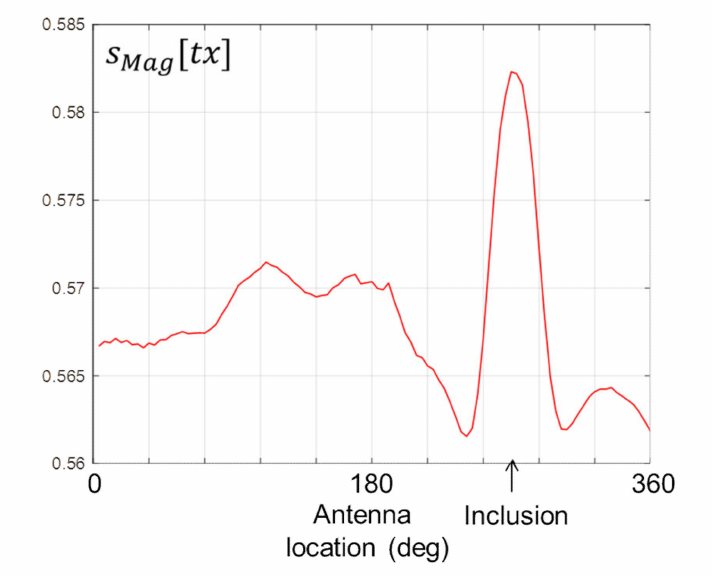
Figure 8. s Mag [ tx ] computed from Equation (5) for scan #1.